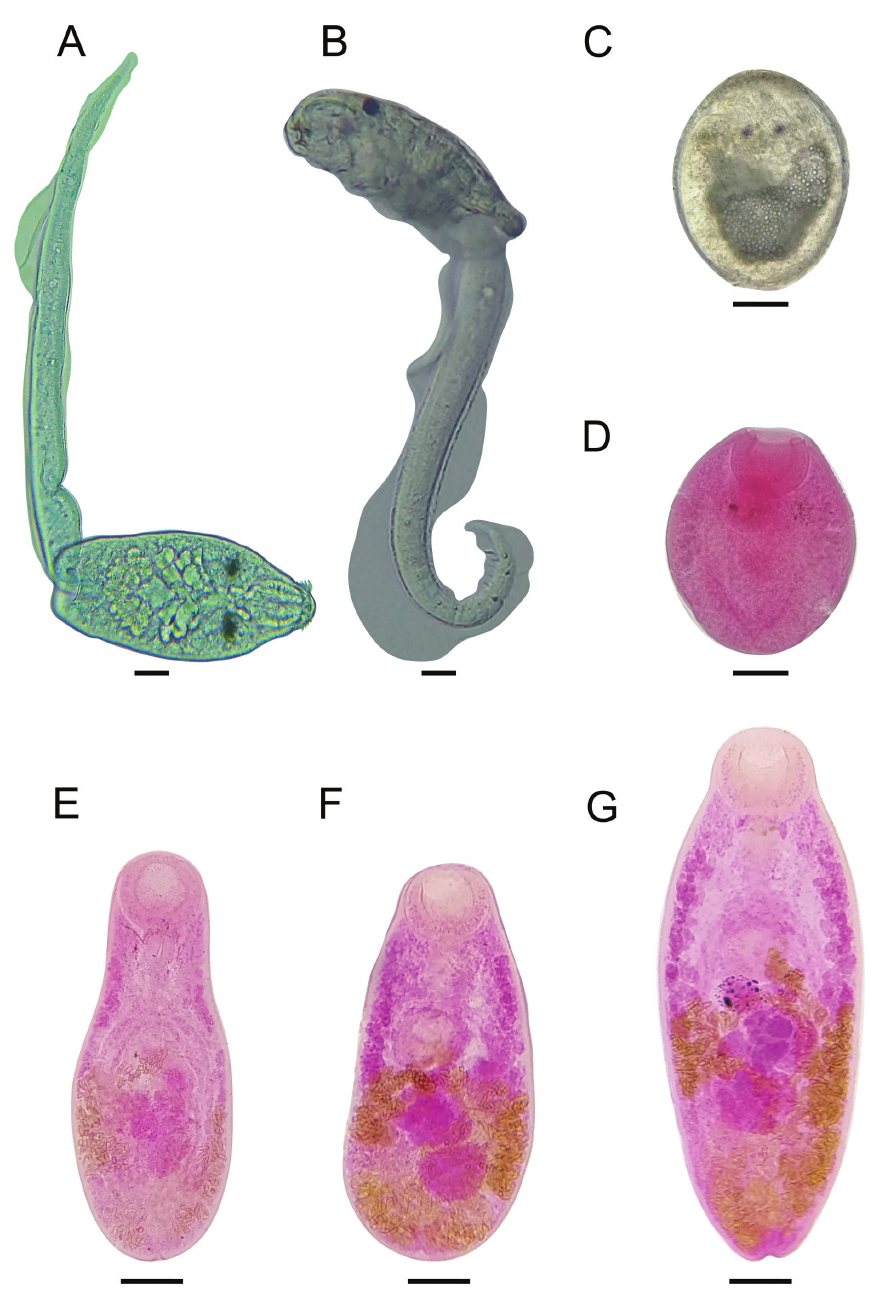
Figure 2. Micrographs of different stages of Oligogonotylus andinus sp. nov. A, B cercariae emerged from Aroapyrgus colombiensis , as temporary mounts C encysted metacercaria from Poecilia caucana , as a temporary mount D unencysted metacercaria isolated from P. caucana , as a permanent slide E, F paratype specimens, as temporary mounts G holotype adult specimen, isolated from A. latifrons , as a permanent slide. Scale bars: 20 µm ( A, B ); 20 µm ( C, D ); 100 µm ( E–G